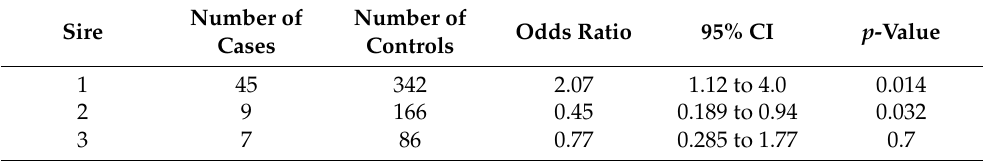
Table 2. Offspring of the three sires born after 2019. Number of Number Sire Cases